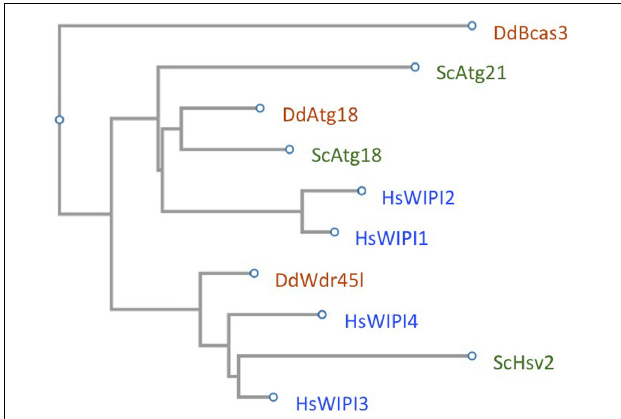
FIGURE 3 | The WIPI family in yeast, Dictyostelium and human. The amino acid sequences of yeast Atg18, Atg21, and Hsv2 (UniProt entry: P43601; Q02887; P50079), Dictyostelium Atg18 and Wdr45l (UniProt entry: Q54NA2; Q54SA0), and the human WIPI1, WIPI2, WDR45B/WIPI3, and